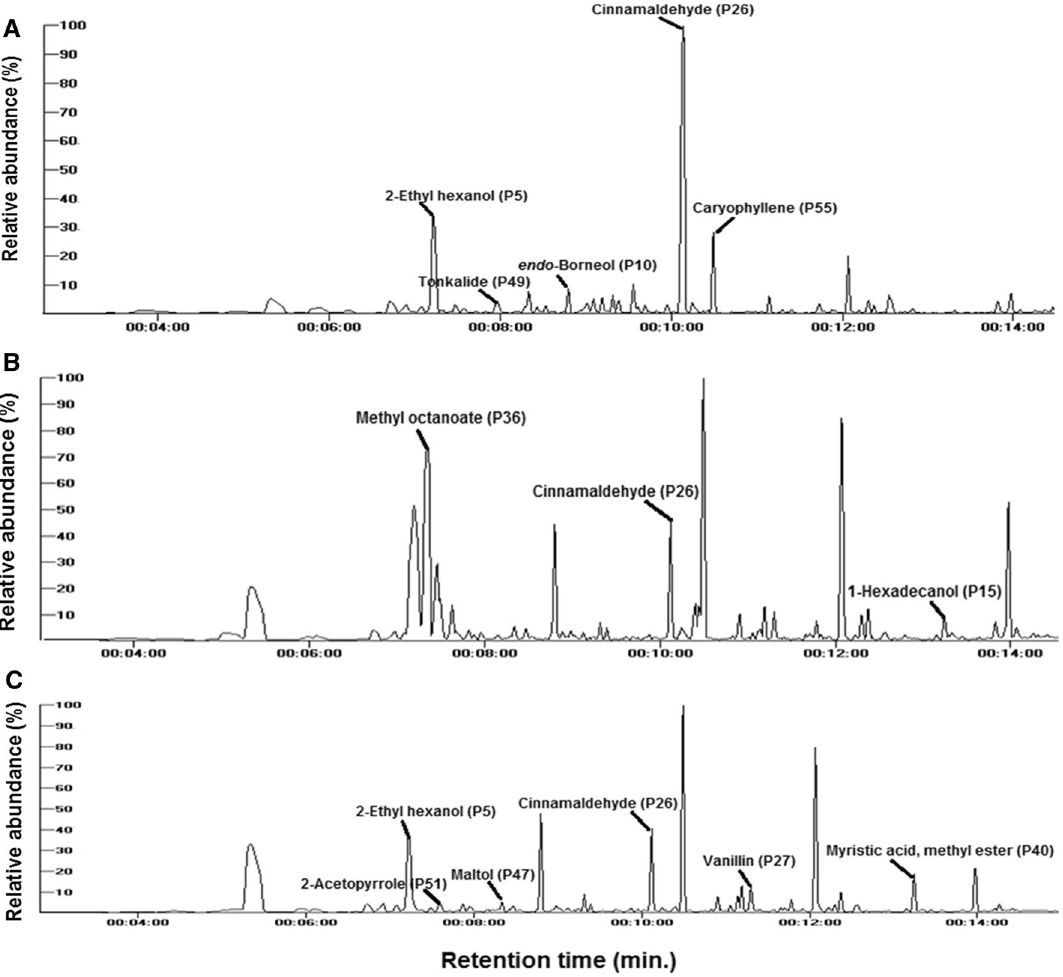
Figure 4. GC–MS total ion chromatograms (TIC) of investigated Eurycoma longifolia (Tongkat Ali) products showing the relative abundances (%) of each identified peaks of; ( A) authentic root powder, ( B) Nu-prep LELAKI ® , and ( C) and Naturelle ® specimens highlighting major aroma component in each